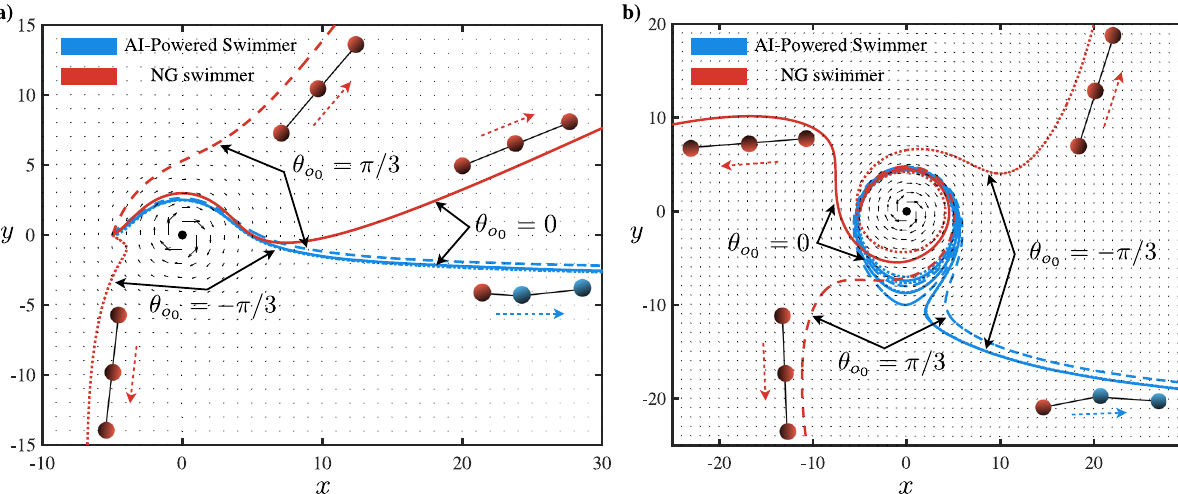
Fig. 6 Analysis of the performance of targeted navigation under the in fl uence of fl ows. a The Arti fi cial Intelligence powered swimmer and the Naja fi – Golestanian (NG) swimmer escape from a relatively weak rotlet fl ow, u ∞ = − γ × r / r 3 , where γ = γ e z prescribes the strength of the rotlet in the z - direction, r = ∣ r ∣ is the magnitude of the position vector r from the origin ( γ = 0.15). The leftmost sphere of the AI-powered swimmer is marked as red and other spheres are marked as blue to indicate the swimmer's current orientation (blue dashed arrow). The NG swimmer is colored red with its orientation marked as red dashed arrows. Three sets of trajectories (dashed, dotted, and solid lines) are shown with different initial swimmer orientation θ o powered swimmer travels to the right regardless of its initial orientation whereas the trajectory for the NG swimmer is highly affected by the rotlet fl ow. b We compare the trajectories of the AI-powered swimmer and the NG swimmer in a strong rotlet fl ow ( γ = 1.5). The NG swimmer completely loses control in the fl ow, while the AI-powered swimmer maintains its orientation towards the positive x -direction, with similar trajectories for different initial orientations. The animation of the two simulations are shown in Supplemental Movies 5 and